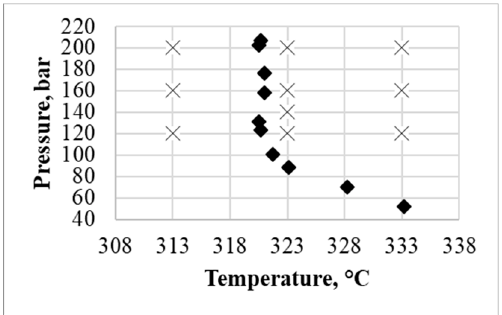
Figure 3. Phase behavior for carbon dioxide and RS-ibuprofen system, p-T projection of solid-liquid-gas line [29] ( ♦) , and parameters of experimental investigation (×).